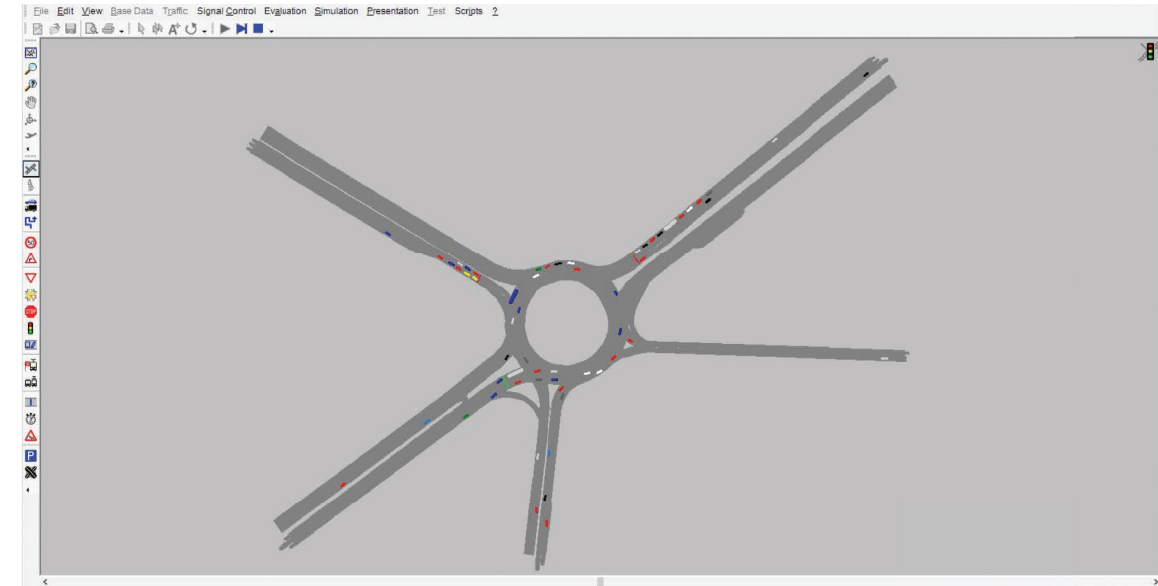
Figure 8: Simulation and comparison of the target roundabout performances using VISSIM. Table 7: Te input and simulated trafc volumes for each approach carriageway (veh).